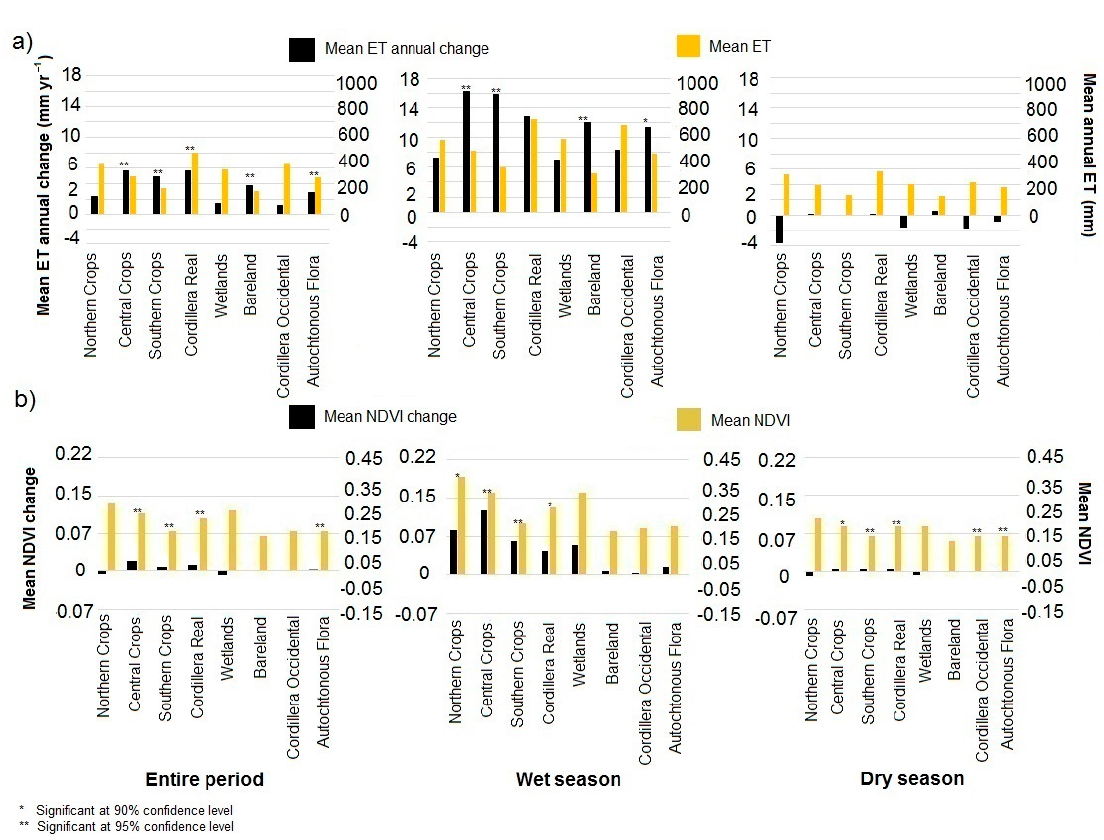
Figure 7. Mean trends and absolute values of ET and NDVI per land cover type and significance level of the trends: ( a ) Mean ET trend (mm yr − 1 ) and mean annual ET (mm); ( b ) mean NDVI change (calculated as the mean trend multiplied by the duration of the study period) and mean NDVI. Table 3. Result of the Mann-Kendall (MK) test for the land cover type trend analysis. NDVI ET